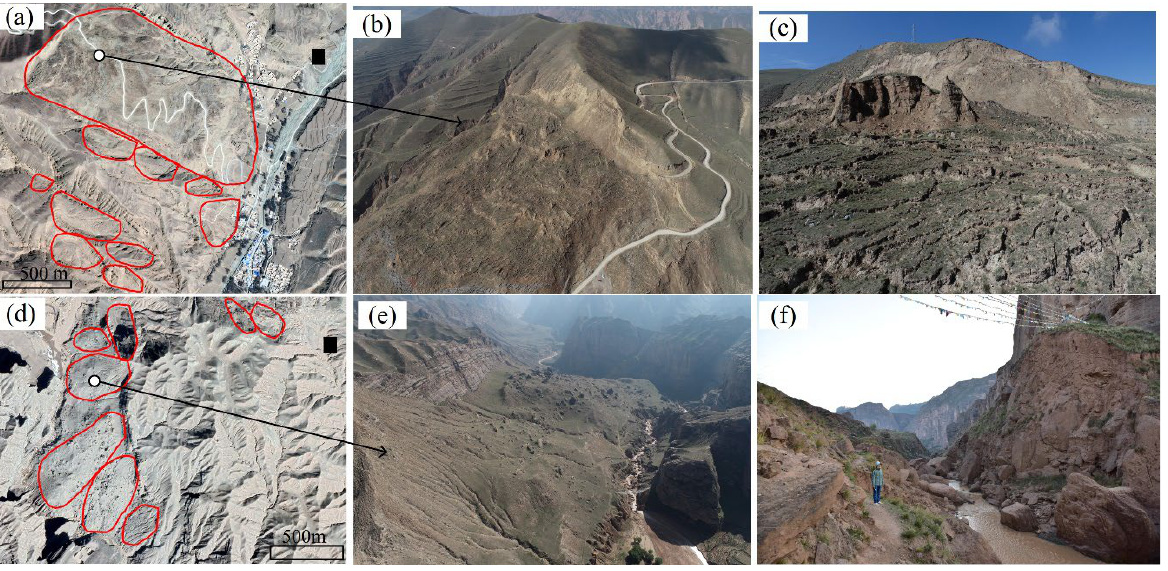
Figure 4. Typical landslide display map. ( a ) Enlarged map of the corresponding location in Figure 3. ( b , c ) Images of the field landslide at different angles, taken from the corresponding location in ( a ), located at 36°4′48″ E, 102°29′59″ N. ( d ) Enlarged map of the corresponding location in Figure 3. ( e , f ) Images of the field landslide at different angles, taken from the corresponding location in ( a ), located at 35°56′3″ E, 102°32′22″ N.